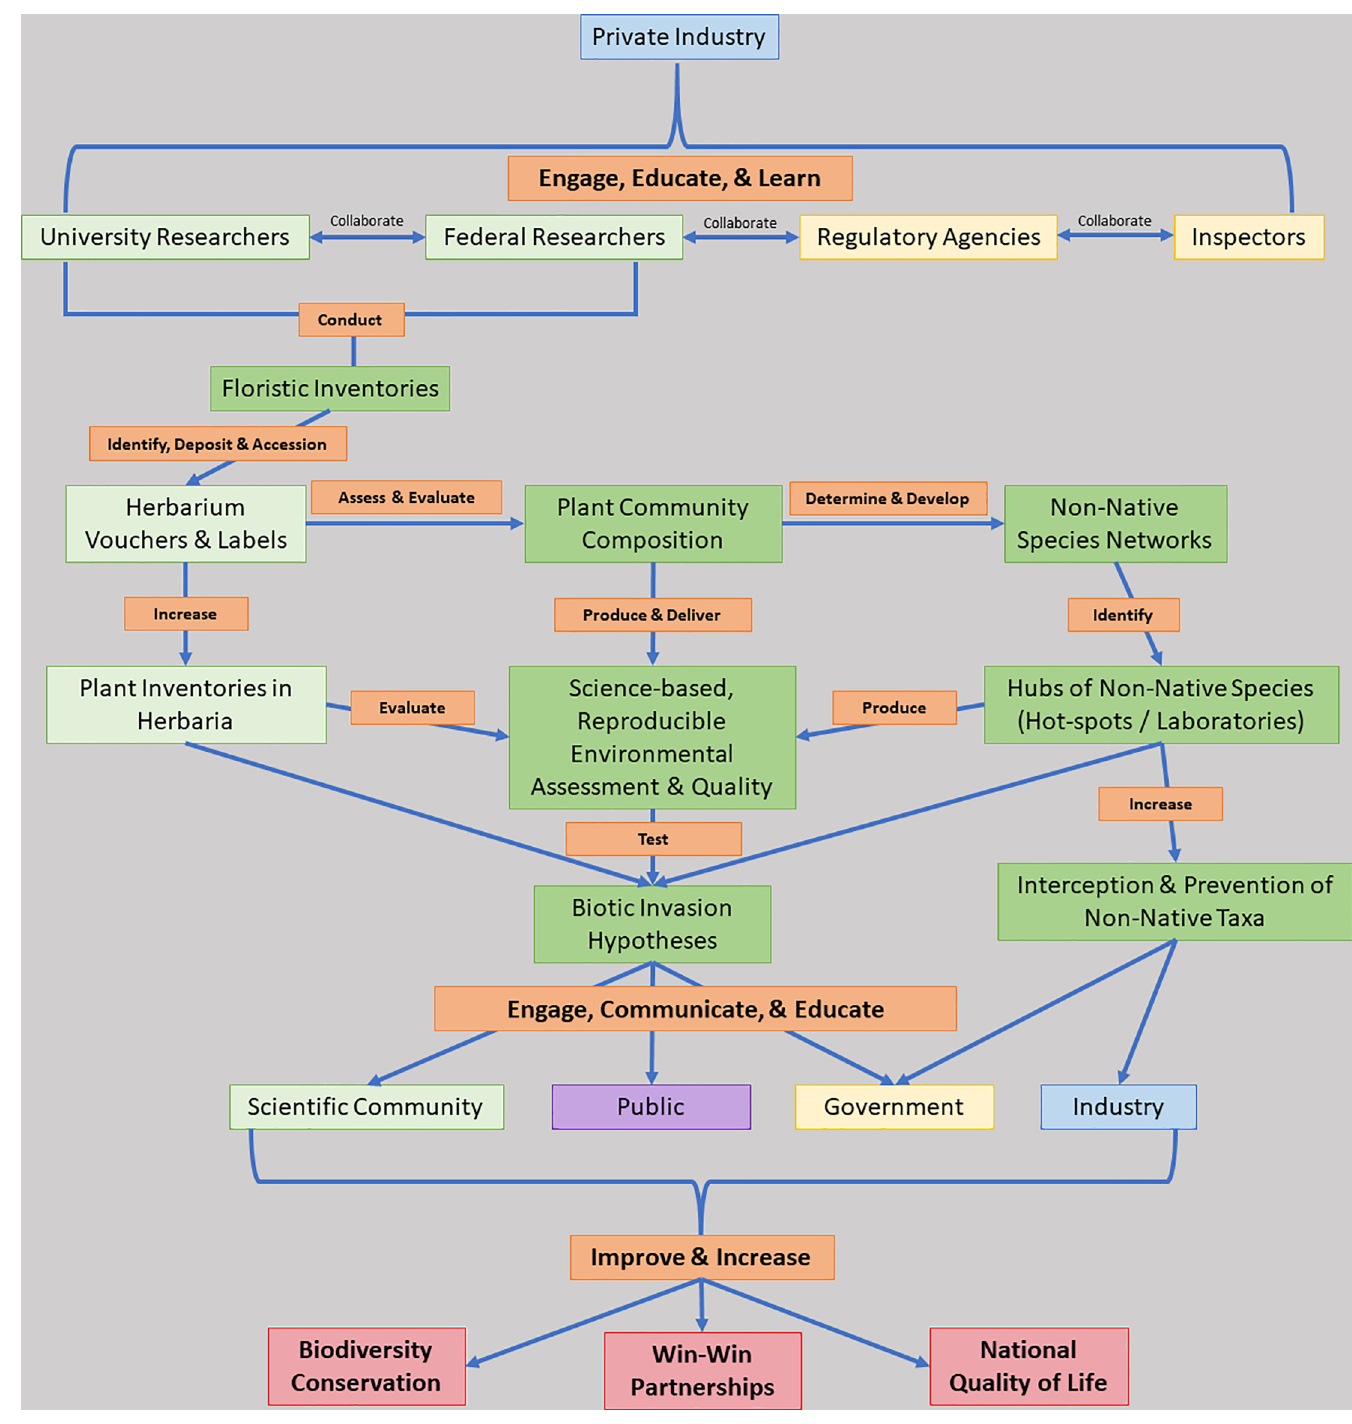
Fig 1. Framework for cooperative interaction across sectors for the purpose of generating meaningful outcomes from Industrialized Flora research at ports-of- entry and industrial sites.